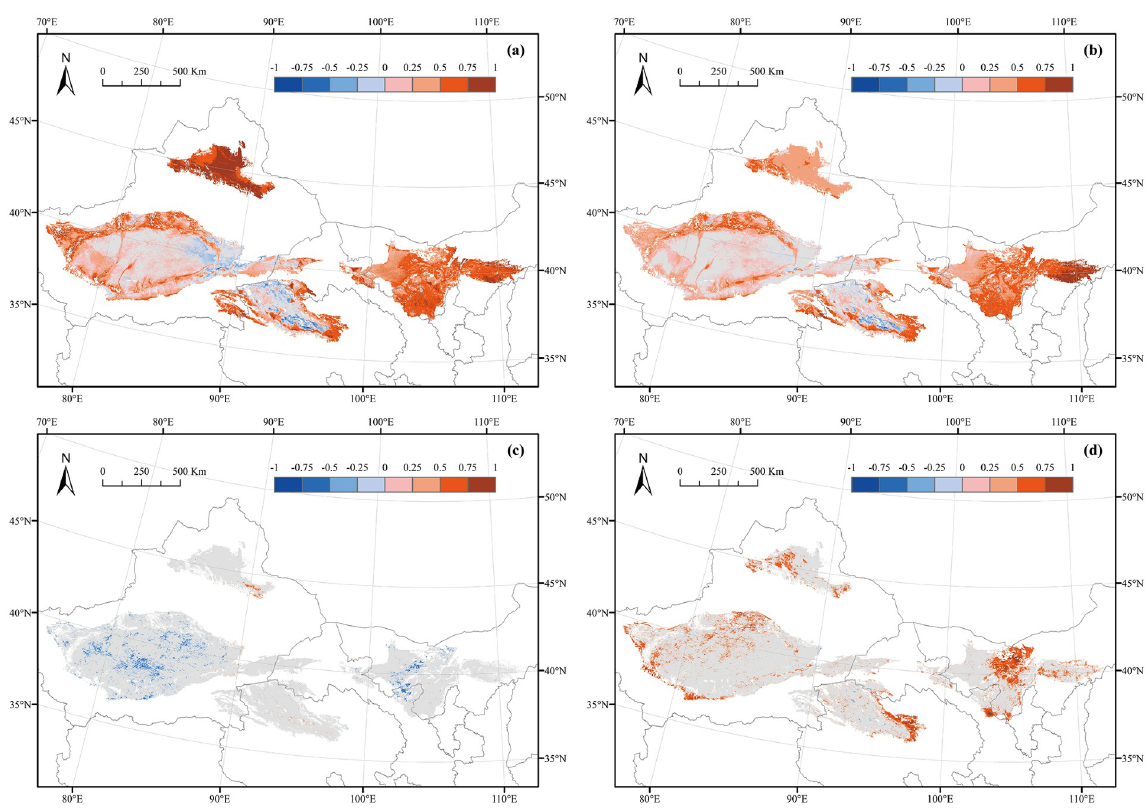
Fig 6. Spatial distribution of the Pearson correlation coefficient for the relationships between the NDVI and climatic factors. (a) Correlation between the monthly NDVI and temperature. (b) Correlation between the monthly NDVI and precipitation. (c) Correlation between the annual NDVI and temperature. (d) Correlation between the annual NDVI and